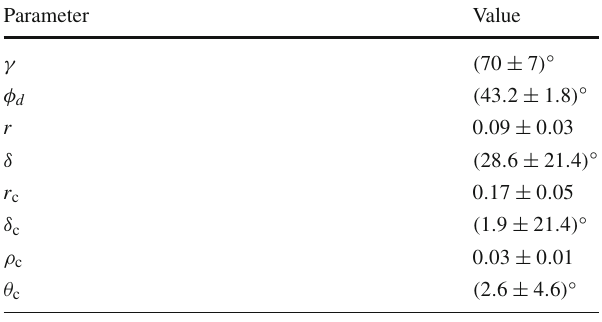
Table 3 Input and hadronic B → π K parameters obtained from the current B → ππ data, including uncertainties from SU ( 3 ) -breaking effects as discussed in Sect.